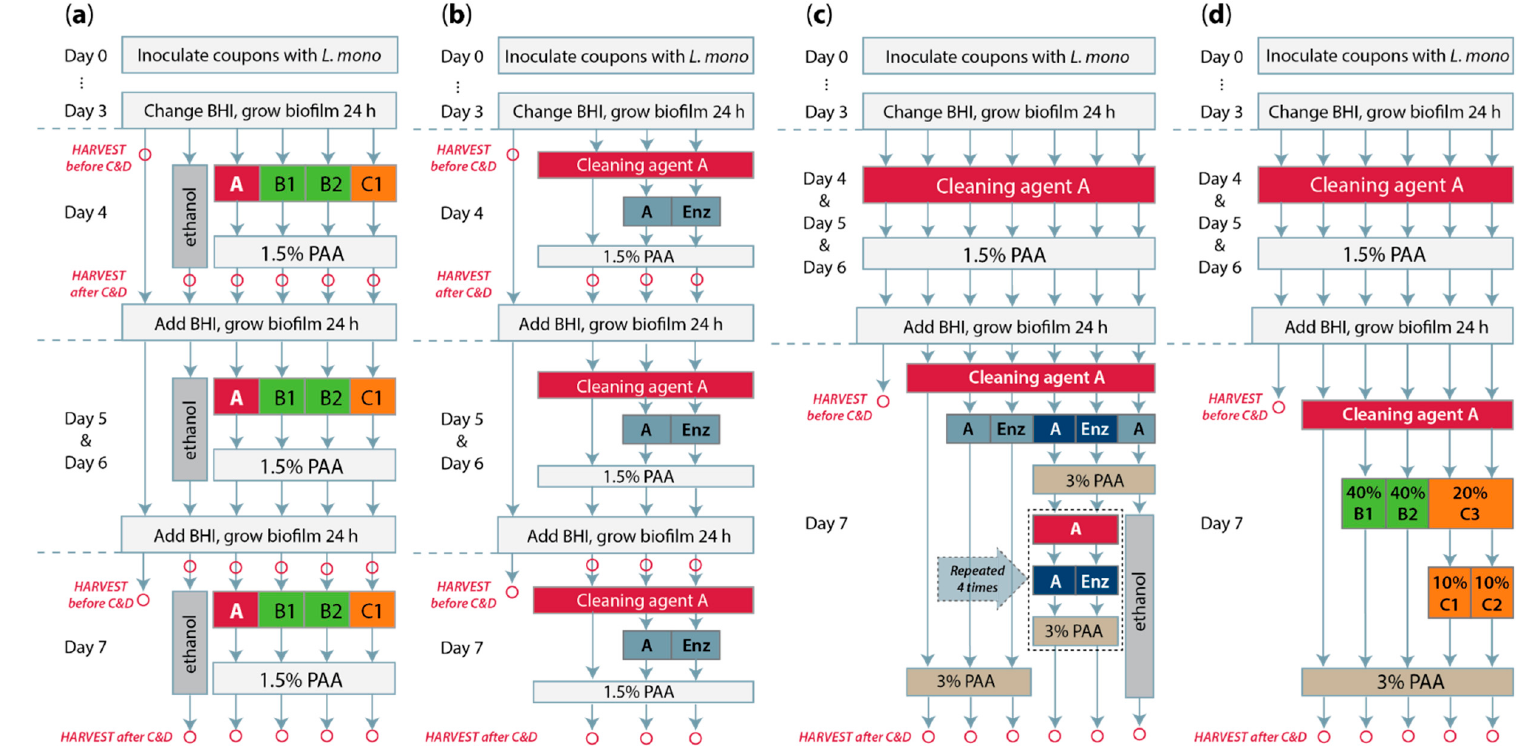
Figure 1. Diagrams illustrating the applied cleaning and disinfection (C&D) treatments. Each arrow represents the step in the protocol where coupons were rinsed three times in H 2 O. Red circles indicate the steps where coupons were harvested for the determination of colony forming units (CFU) coupon − 1 . For steps involving cleaning agent A, red boxes indicate incubation for 10 min at room temperature (RT), while blue boxes indicate incubation for 30 min with cleaning solution pre-heated to 45 °C, and incubation either at ( b ) RT or ( c ) 45 °C. For additional details, see the main text. ( a ) Standard C&D treatment described in Section 2.5.1 and employed in the experiment shown in Figure 2. ( b ) C&D biofilm treatment with the enzymatic cleaning agent described in Section 2.5.2 and Figure 3. ( c ) Reinforced treatment with cleaning agents, see Section 2.5.3 and Figure 4a. The cleaning steps shown in light blue and dark blue boxes («A» and «Enz») represent identical treatments; different coloring (light/dark blue) is employed to coordinate with the colors used in Figure 4a. ( d ) C&D with higher concentrations of chemical cleaners, see Section 2.5.3 and Figure 4b.